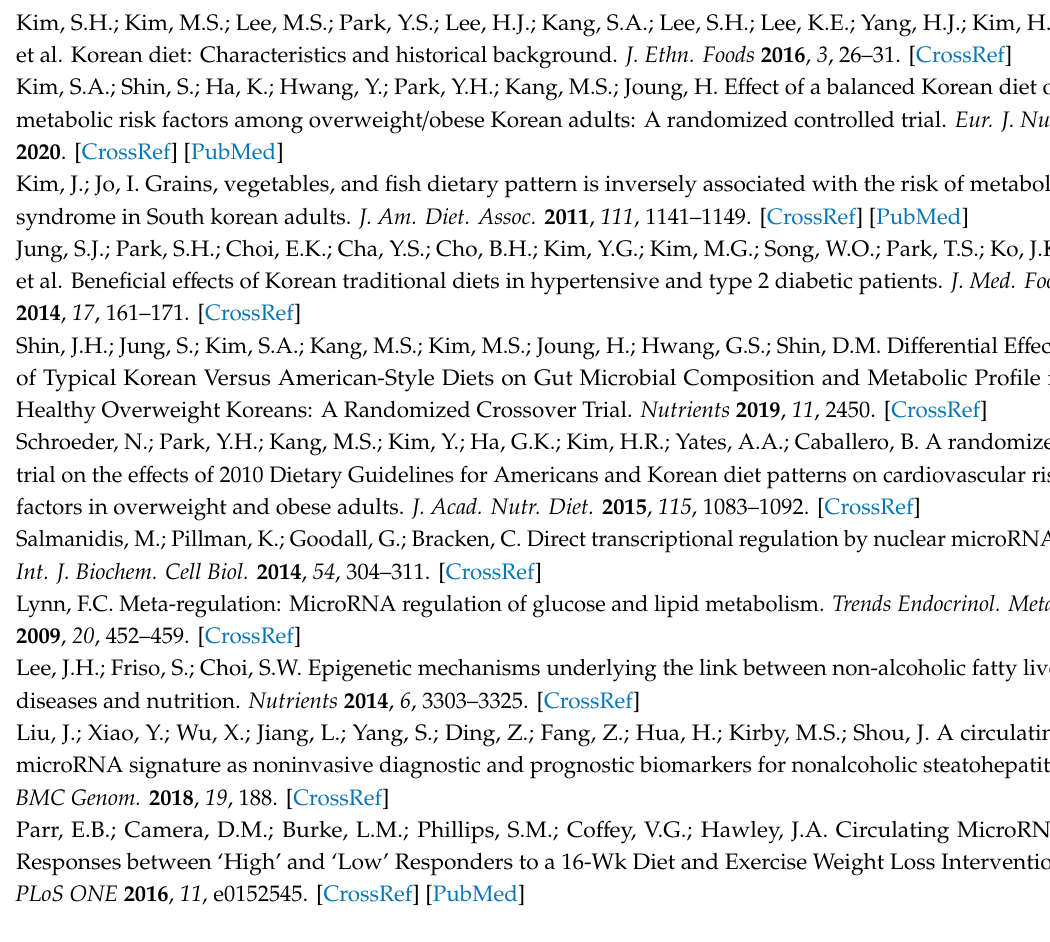
Table S1: MiRs used for the